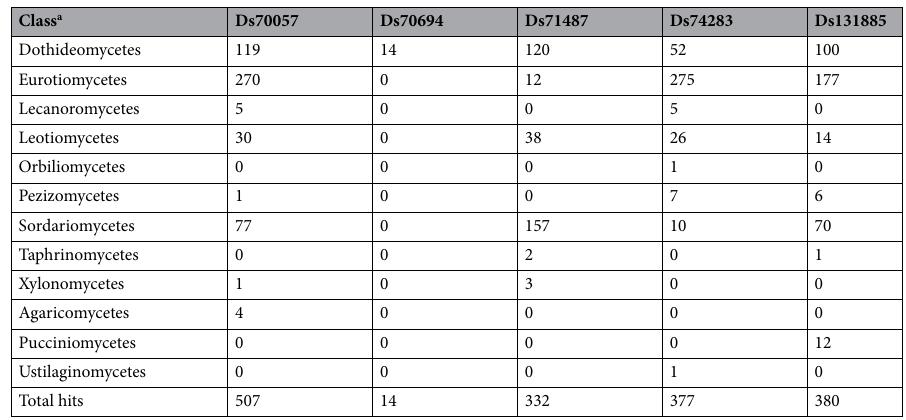
Table 1. BLASTp hits of Dothistroma septosporum cell death elicitors in fungal classes. a The numbers represent the number of species in these classes in which there was at least one BLASTp hit to the D. septosporum cell death elicitors (E < 1e−05) from fungal species for which genomes were available at JGI (details in Supplementary Table S4). The top nine classes are Ascomycetes; the bottom three classes are